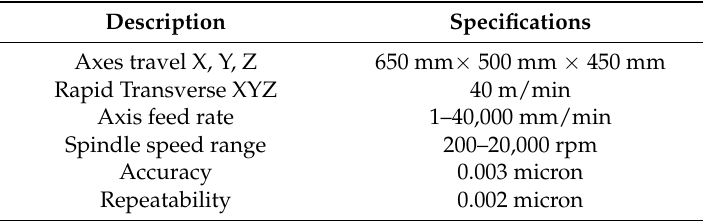
Figure 3. Edge trimming. Table 2. Specification of Makino S33